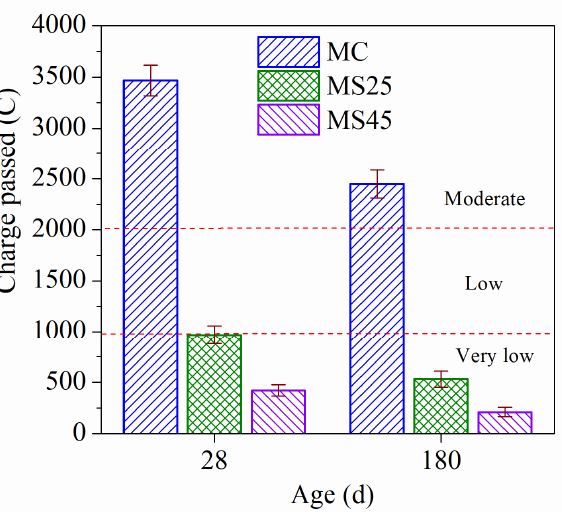
Figure 5. Chloride ion penetrability resistance of high-strength concrete under temperature-matching curing conditions.